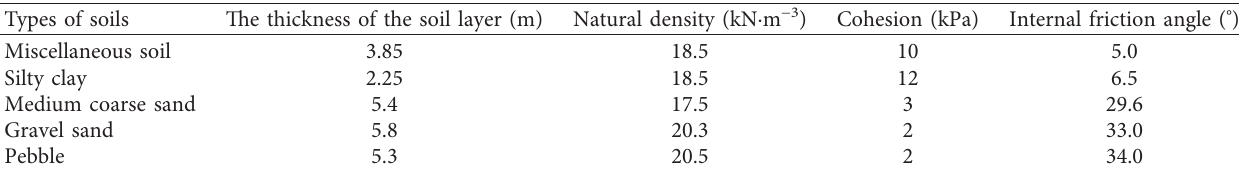
Figure 7: The finite element model. Table 2: Physical and mechanical parameters of surrounding